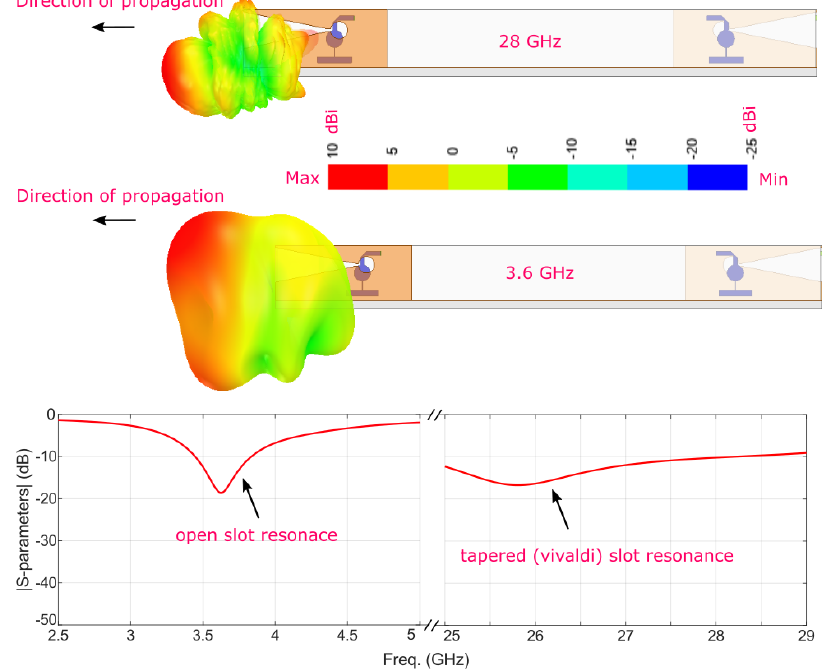
Figure 3. The performance of the proposed MIMO antenna design when only Ant. 1 is excited (op- erating). Due to large inter-antenna element spacing and antenna placement orientation, the isolation (coupling) between adjacent antenna elements is low, i.e., more than 17 dB be- tween Ant. 1 and Ant. 2. Moreover, the MIMO design has four directional radiation beams pointing to four different locations ( φ = 180°, φ = 0°, φ = − 90°, and φ = 90°) in the azimuth plane (the X-Yplane) at both the 3.6 GHz and the 28 GHz bands. This indicates a low cor- relation coefficient ( ρ ) value between adjacent antenna radiation beams, i.e., between Ant.